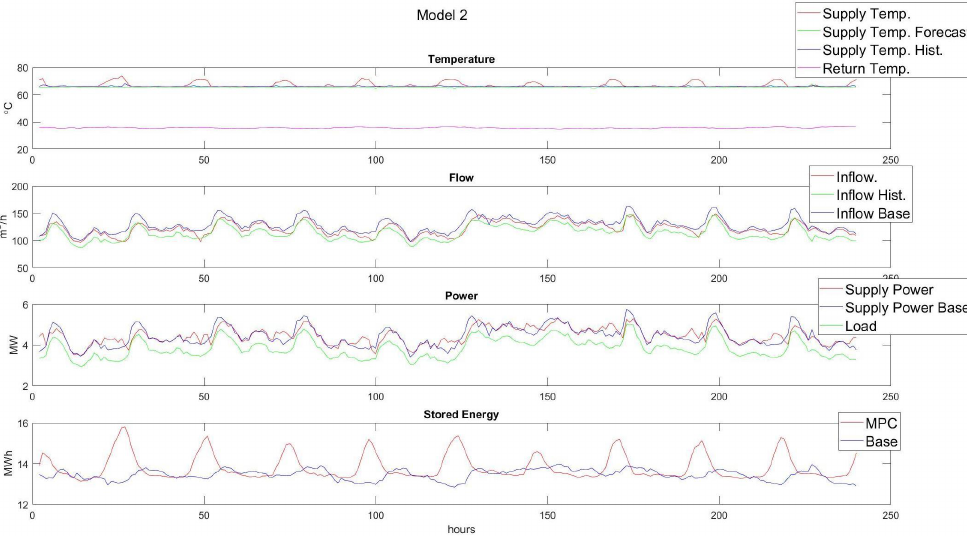
Figure 7. Performance results of model 2, inducing peak shaving with increases in stored energy. MPC results (red), base simulation (blue), and historic results